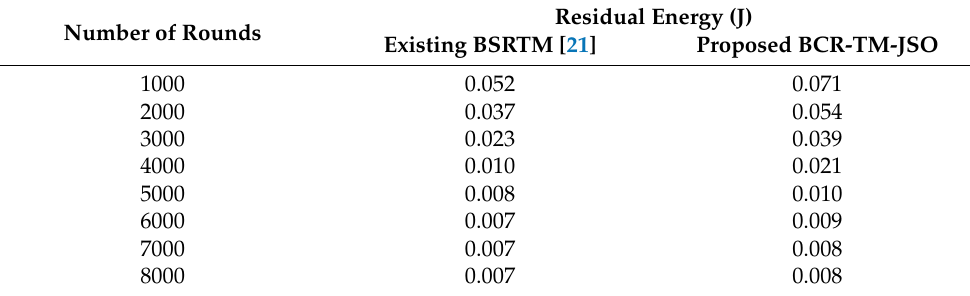
Table 6. Performances of network lifetime in terms of residual energy.